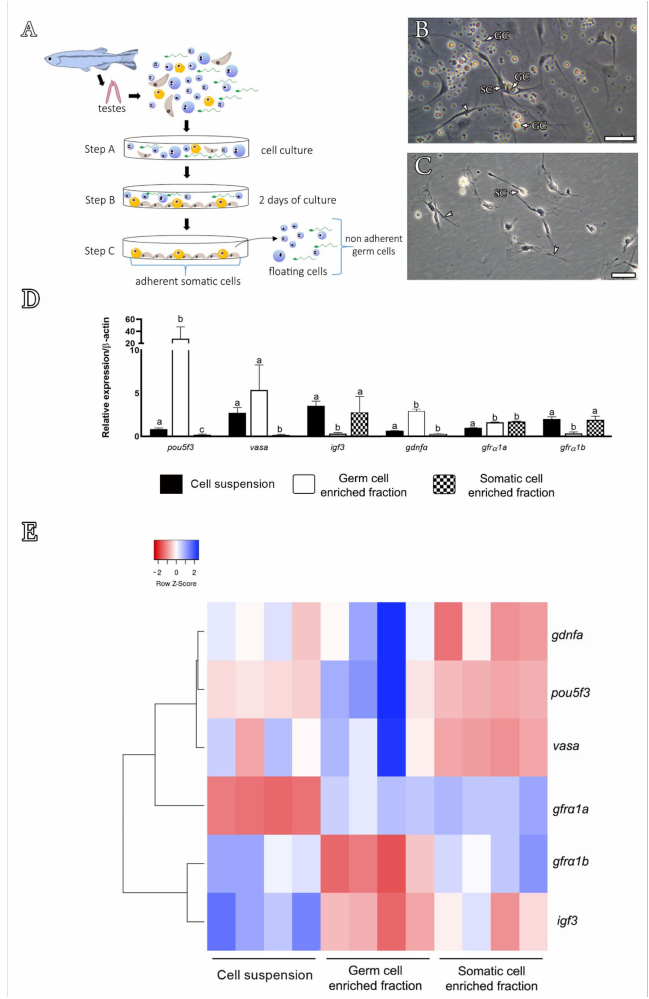
Figure 4. Differential plating method and expression analysis of the cellular enriched